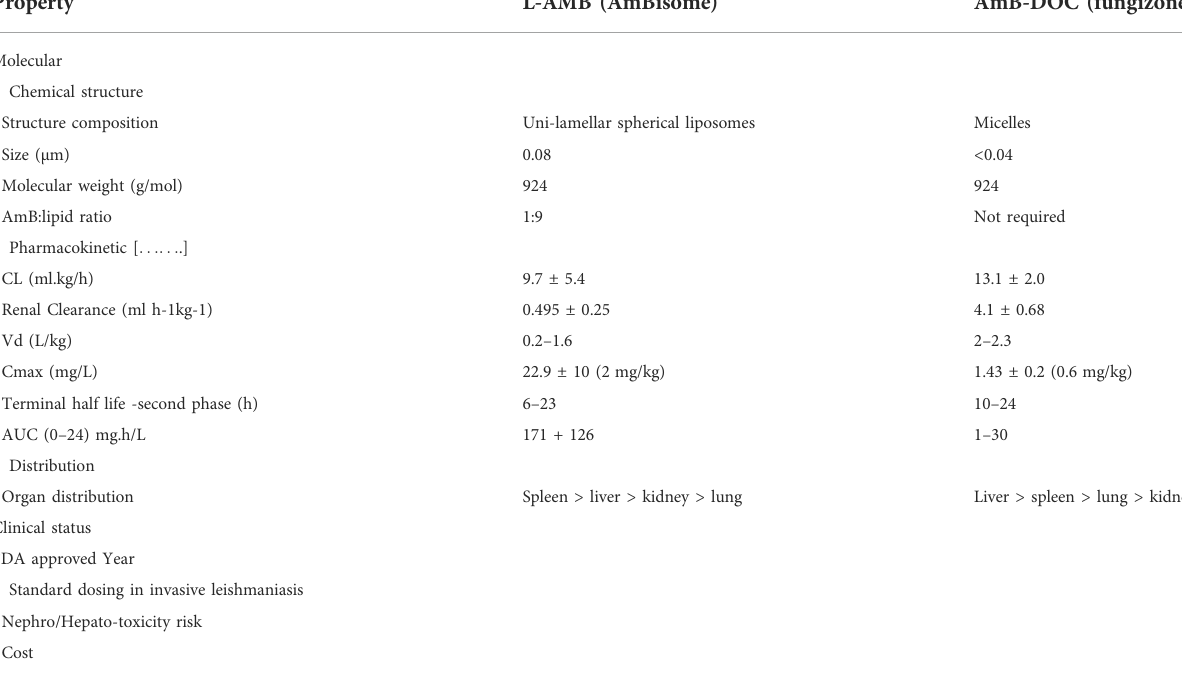
TABLE 2 Pharmacokinetics and pharmacodynamics parameters are compared between most important formulation of AmB.